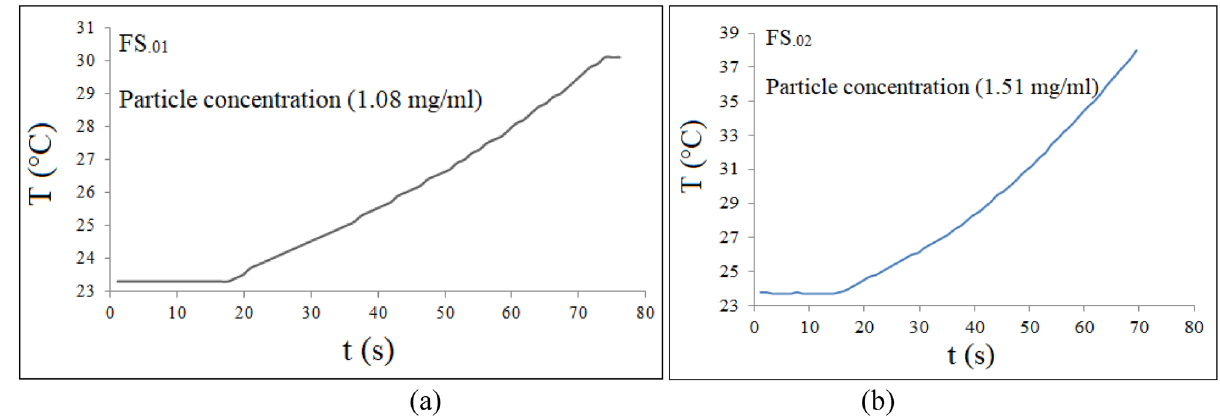
Figure 12. The variation of the temperature with respect to time of the liquid ferrofluids in an RF magnetic decreased by increasing the Sm 3+ content, which related to properties of the nanoparticles, such as size, size distribution and morphology. VSM measurements on all ferrofluids presented nonzero coercivities, which are results of both multidomain cores and agglomeration of the coated nanoparticles in the solution. The highest obtained values of the SLP and ILP were 259 W/g and 3.49 nHm 2 /kg, respectively, which were found for the FS .01 sample at a concentration as low as 1.08 mg/ml. Those high values are due to the nonzero coercivity of the samples that leads to a hysteresis loss portion as the main loss mechanism, although frictional loss may have occurred additionally too. From the SLP and ILP data, we concluded that both FS .01 and/or FS .02 samples are good candidates for magnetic hyperthermia applications potentially to achieve sufficient heating efficiencies at a low magnetic nanoparticles concentration.